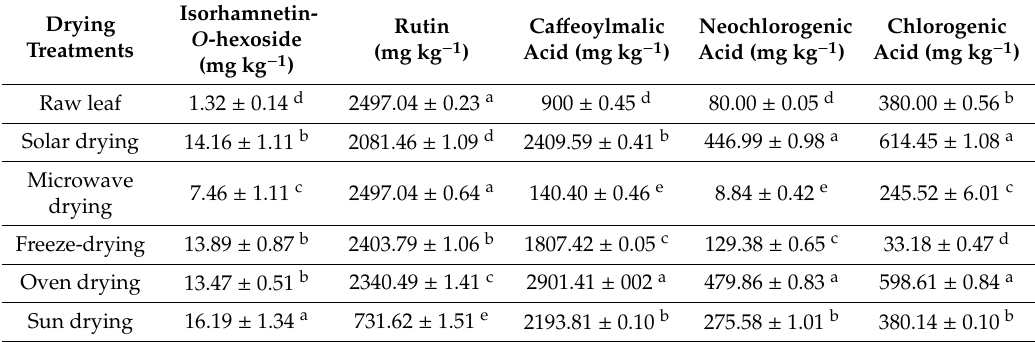
Table 6. Influence of drying treatments on flavonoid glycosides and hydro cinnamic acid esters in